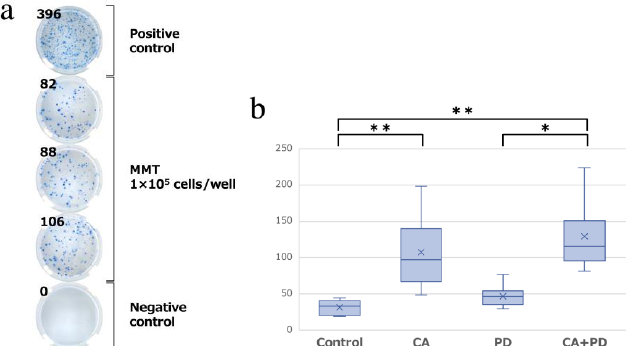
Figure 3. ( a ) Representative findings of the well design. The result of the No. 3 sample in the CA group. ( b ) The results of the ELISPOT assay. There was a significant difference in the number of spots between the Control group and the CA, CA + PD groups (** p < 0.01). There was also a signif- icant difference in the number of spots between the PD group and the CA + PD group (* p < 0.05).